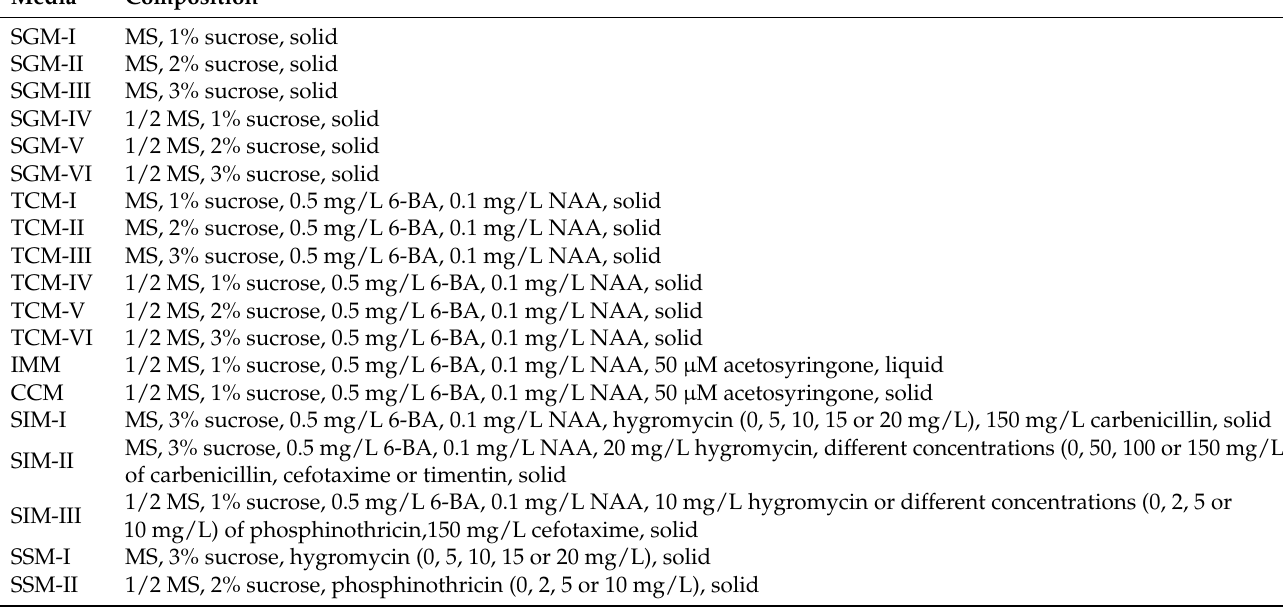
Table 2. Composition of media used in this